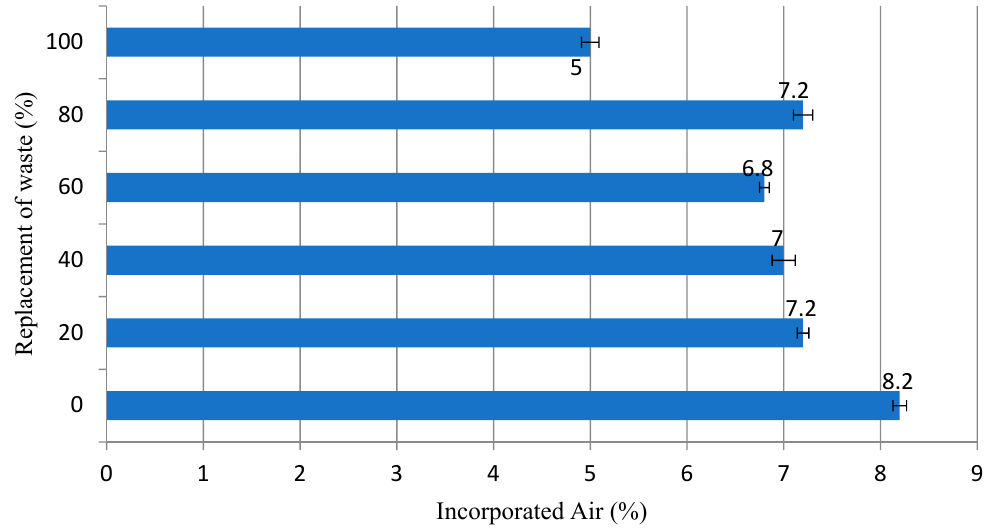
Figure 6. Result of the incorporated air content (%) in the evaluated mortars.